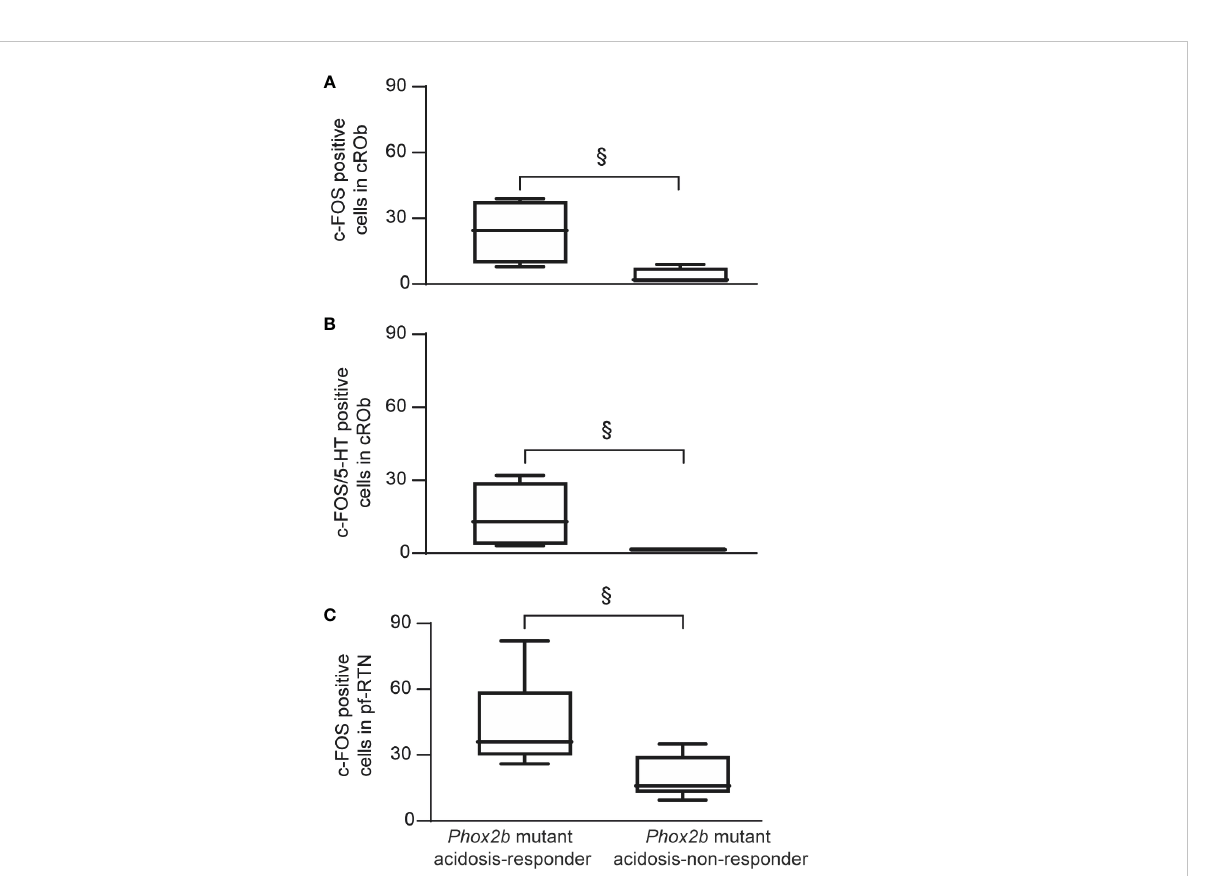
FIGURE 5 Graphical representation of the increase in number of c-FOS or c-FOS/5-HT positive cells in ROb and pf-RTN in Phox2b mutant acidosis-responder compared to acidosis non-responder under metabolic acidosis with etonogestrel. Box and whisker (median [Q1; Q3] and minimum and maximum values) showing the c-FOS (A, C) or c-FOS/5-HT (B) positive cells in the cROB (A, B) and pf-RTN (C) . ( § p < 0.05; Mann & Whitney test). cROb (caudal part of the raphe obscurus nucleus; from pyramidal decussation to rostral edge of the inferior olive); pf-RTN (parafacial retrotrapezoid nucleus; in ventromedial position under the facial